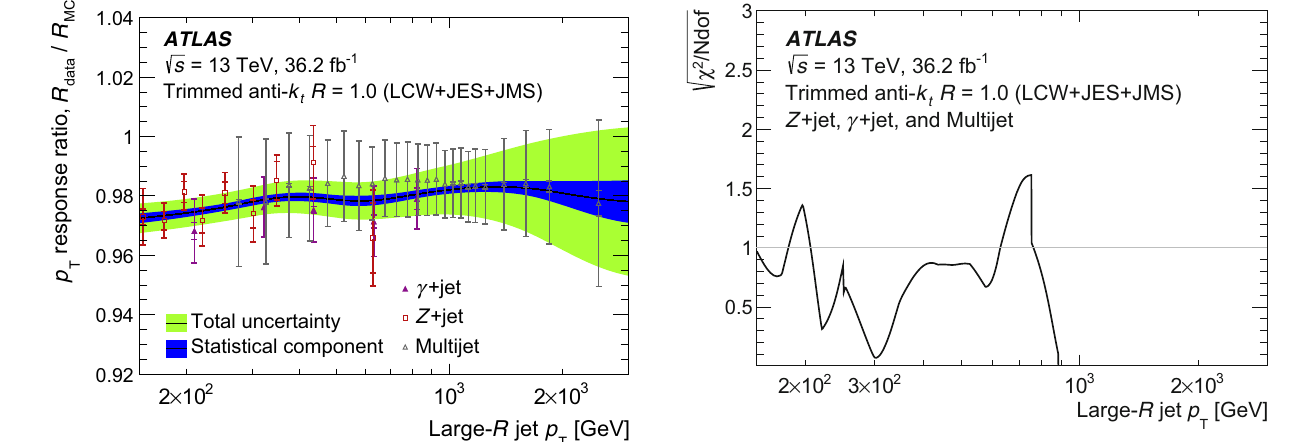
Fig. 25 Data-to-simulation ratio of the average jet p T response as a function of large- R jet p T . The combined result (band) is based on threeinsitutechniques:the Z +jetbalancemethod(opensquares), γ +jet balance method (closed triangles), and the multijet balance (open trian- gles). The errors represent the statistical (inner error bars) and the total uncertainty(statisticalandsystematicuncertaintiesaddedinquadrature, outererrorbars).Theresultsapplytotrimmedanti- k t jetswith R = 1 . 0. The lines shown are smoothed using a sliding Gaussian kernel